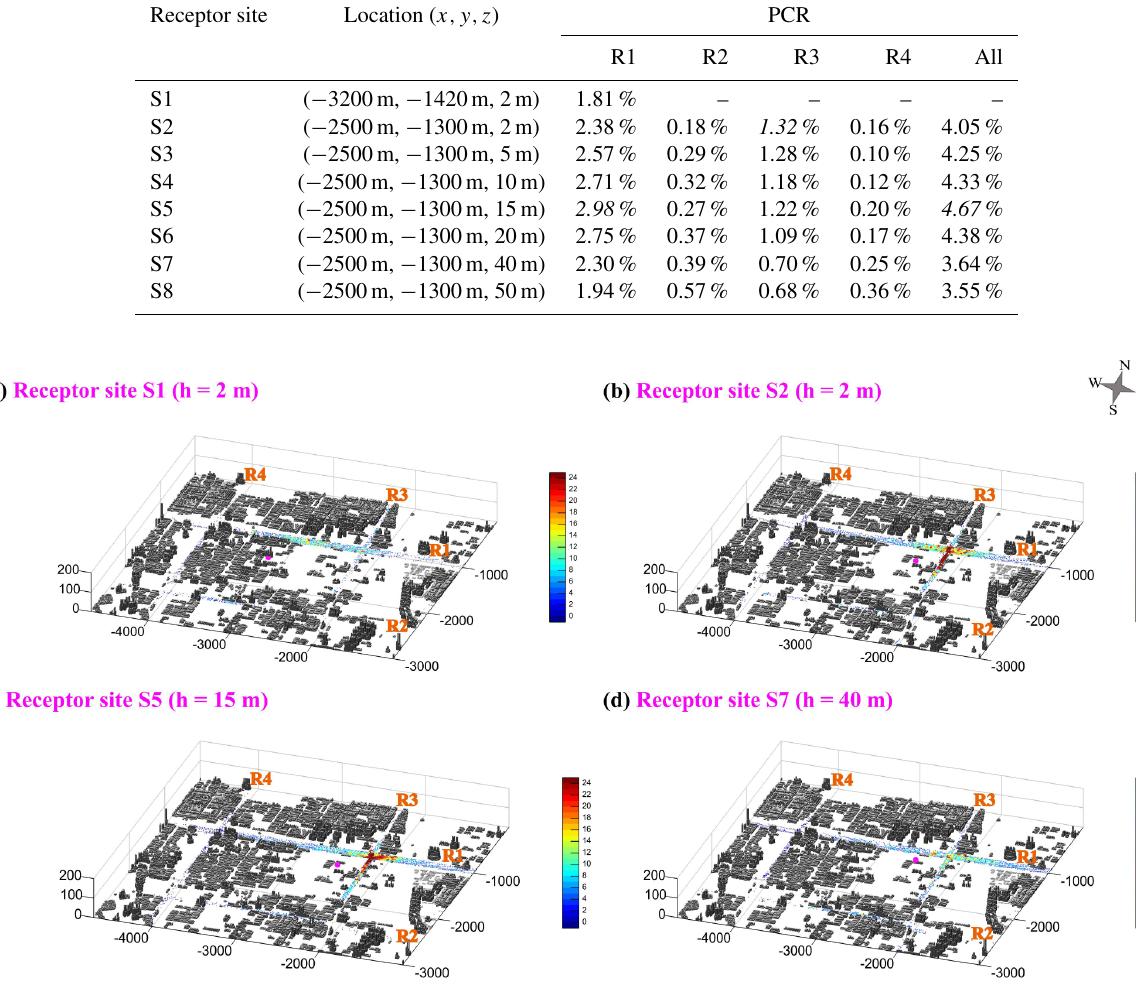
Figure 7. Density distribution on the road of backward trajectory particles released from different receptor sites (S1, S2, S5, and S7; see details in Table 4). The four receptor sites are all marked with magenta